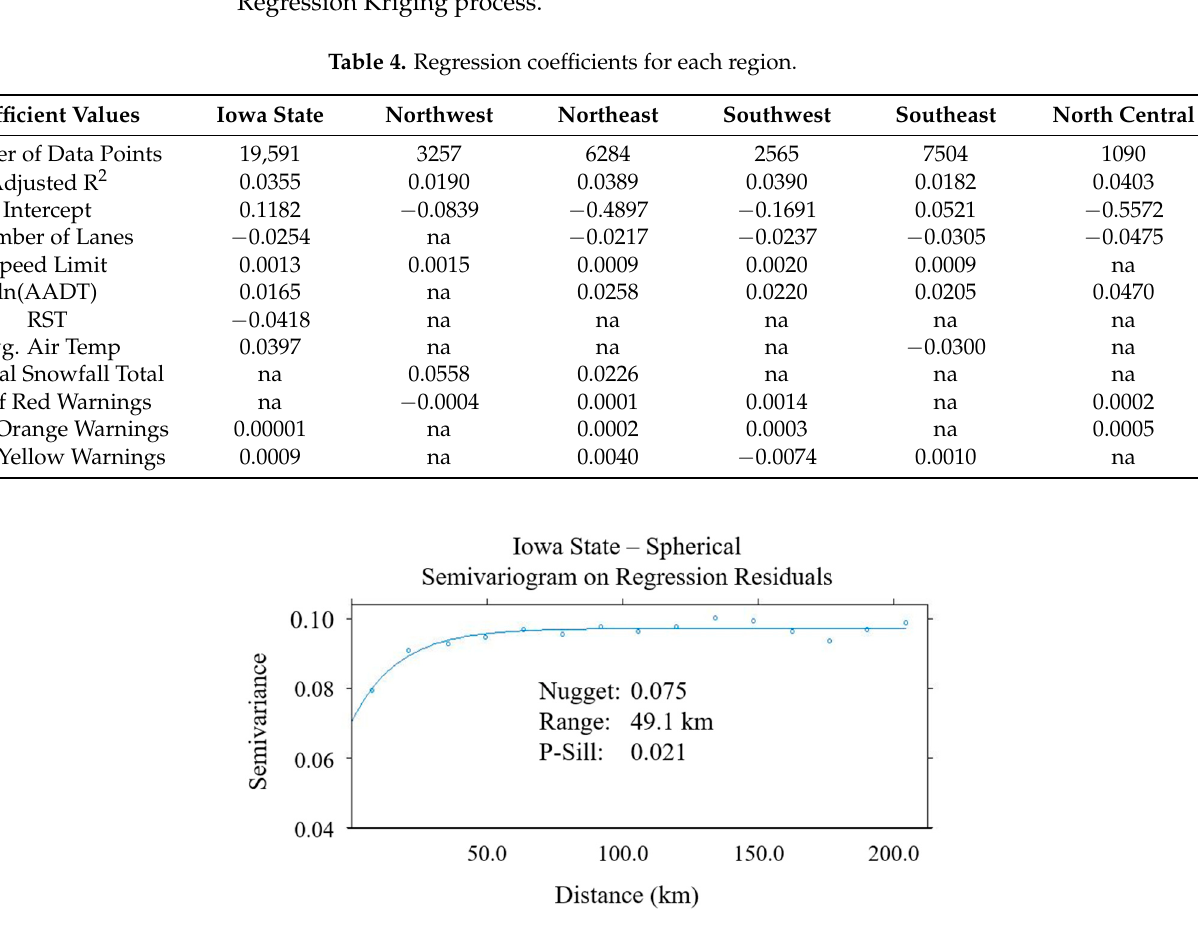
Figure 10. Semivariogram for the state of Iowa RK residuals.